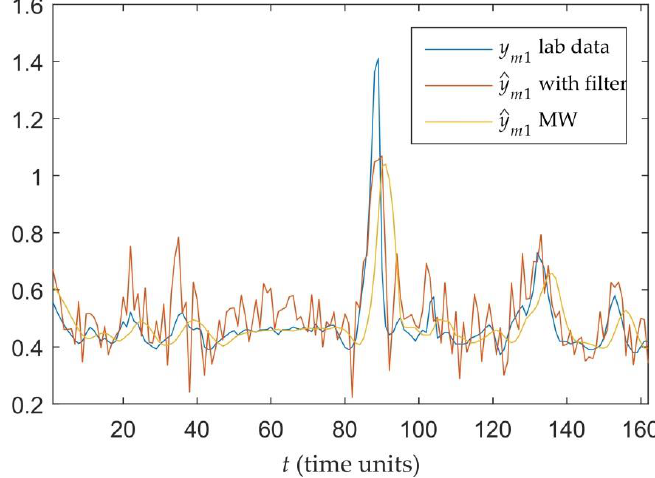
Mathematics 2021 , 9 , x FOR PEER REVIEW